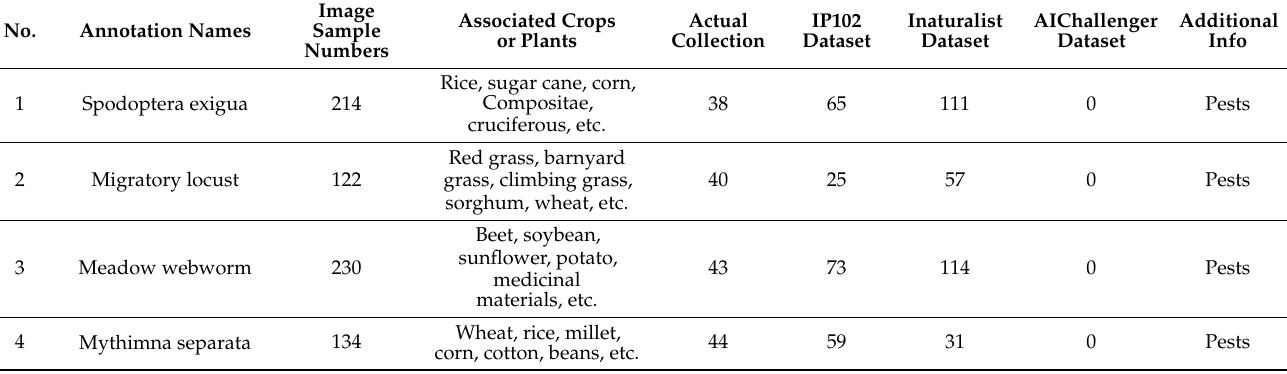
Table A1. CropDP-181